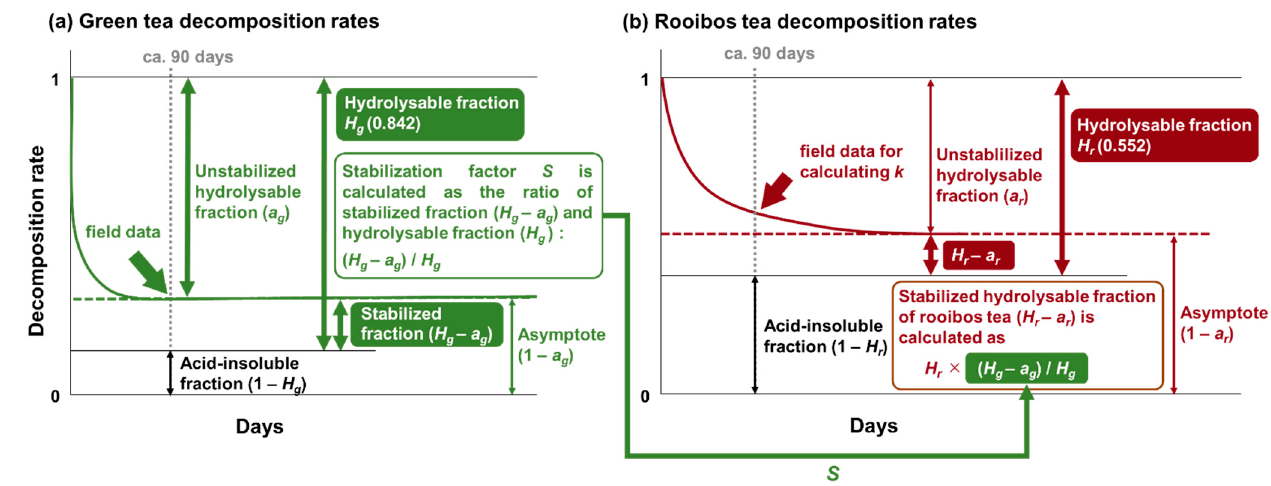
Figure 1. The concept of the Tea Bag Index (TBI) approach. The figure is modified from Mori (2022) [7]. The ( a ) left and ( b ) right figures are the decomposition curves of green and rooibos teas, respectively. a g and a r are the unstabilized hydrolysable fractions of green and rooibos teas, respectively. H g (0.842) and H r (0.552) are the hydrolysable fractions of green and rooibos teas, respectively. The S in the figure indicates S_TBI . The decomposition constant k ( k_TBI ) can be determined by fitting an asymptote model ( Mass of rooibos tea remaining = a r × e –k×t + (1 − a r ), see Equation (4)), to the mass of rooibos tea remaining at the end of the approximately 90-day incubation.